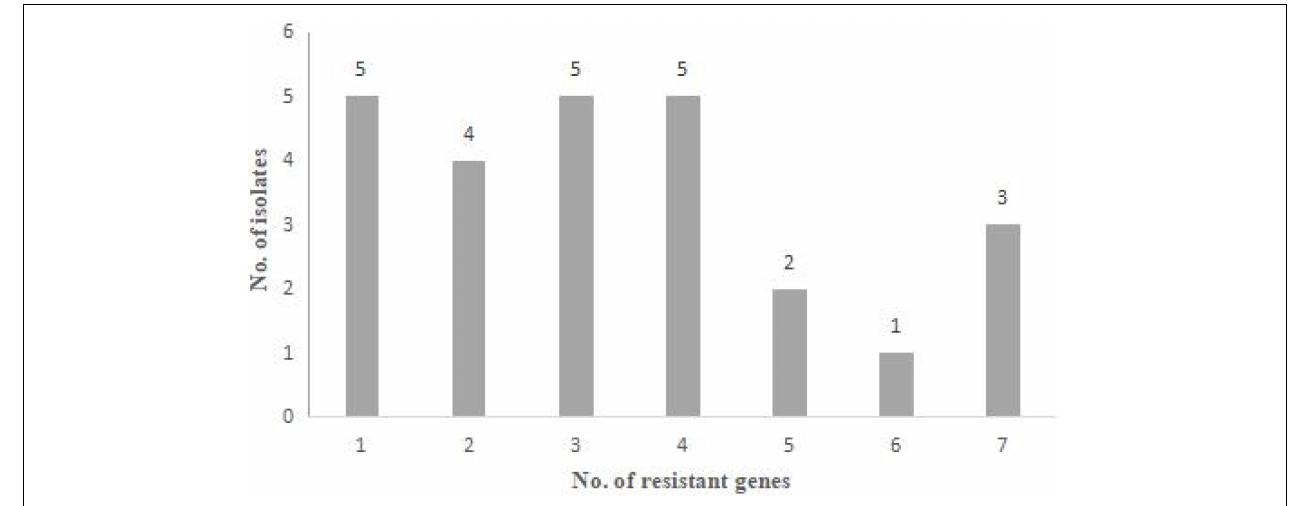
FIGURE 2 | Antibiotic resistance genes of 26 Staphylococcus aureus strains. Distribution of the number of antibiotic resistance genes that the strains harbored.